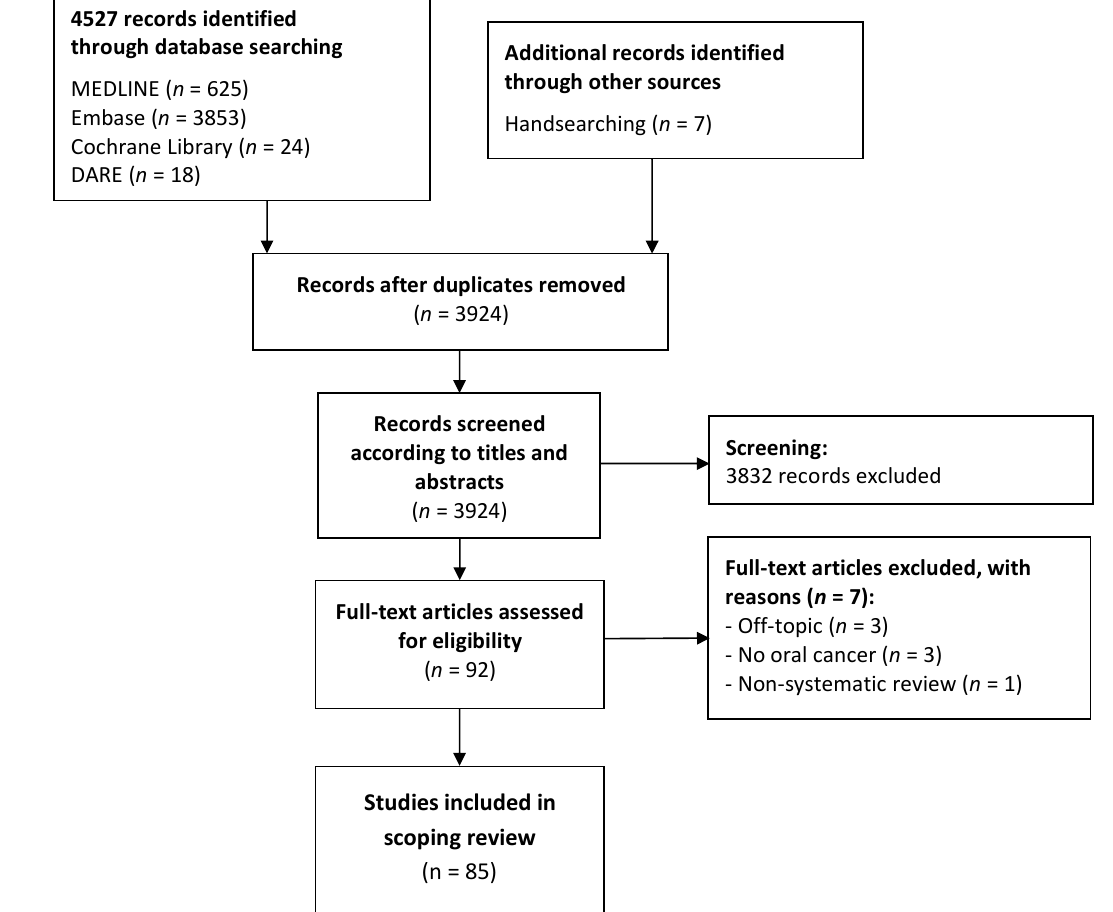
Figure 1. Flow diagram of the identification and selection process of the studies included in this scoping review of systematic reviews.